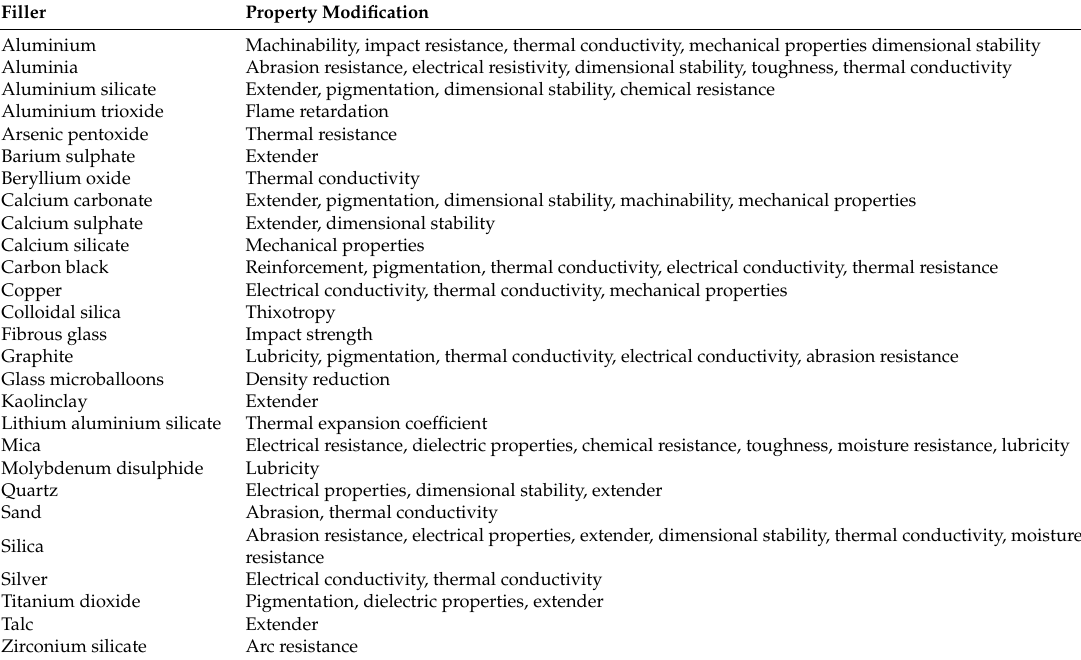
Table 2. Example of filler types and potential property modification, data from